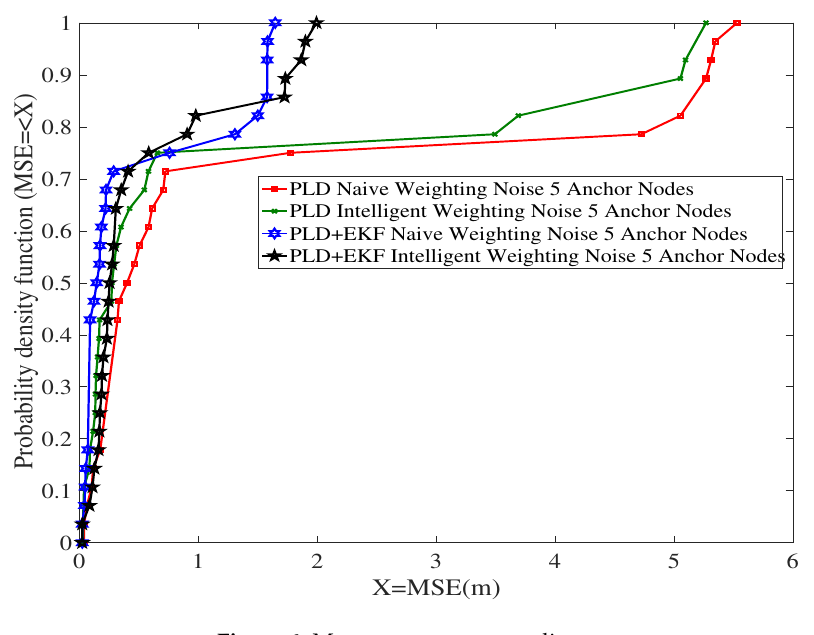
Figure 6. Mean square error vs. distance.